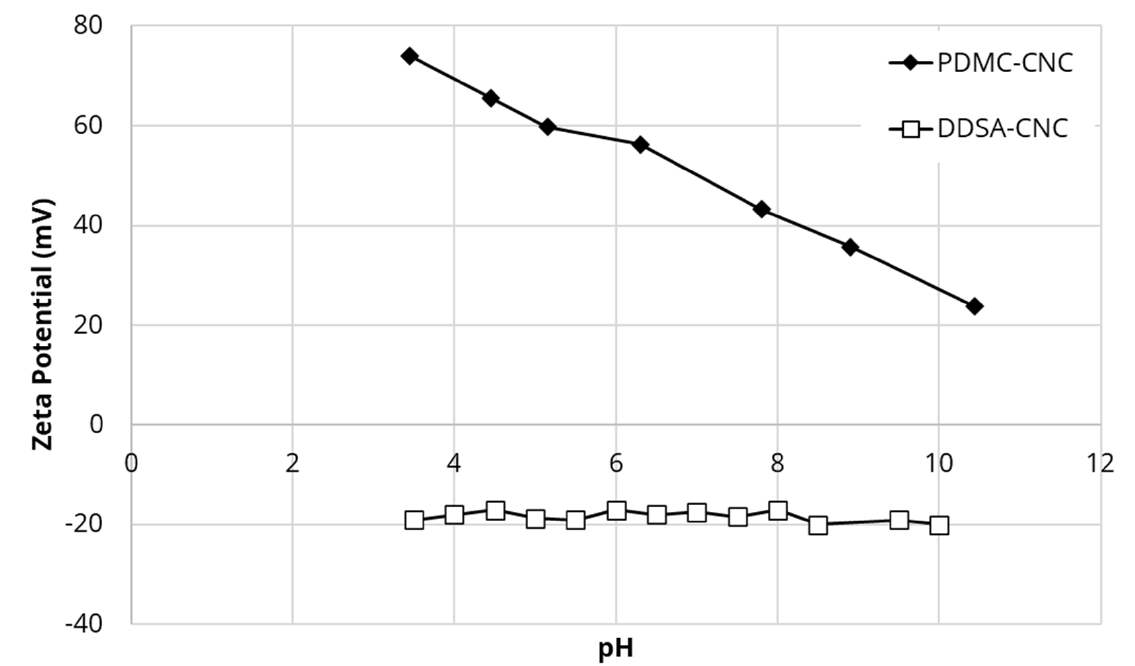
Figure 5. Zeta potential of covalently modified CNC as a function of pH.